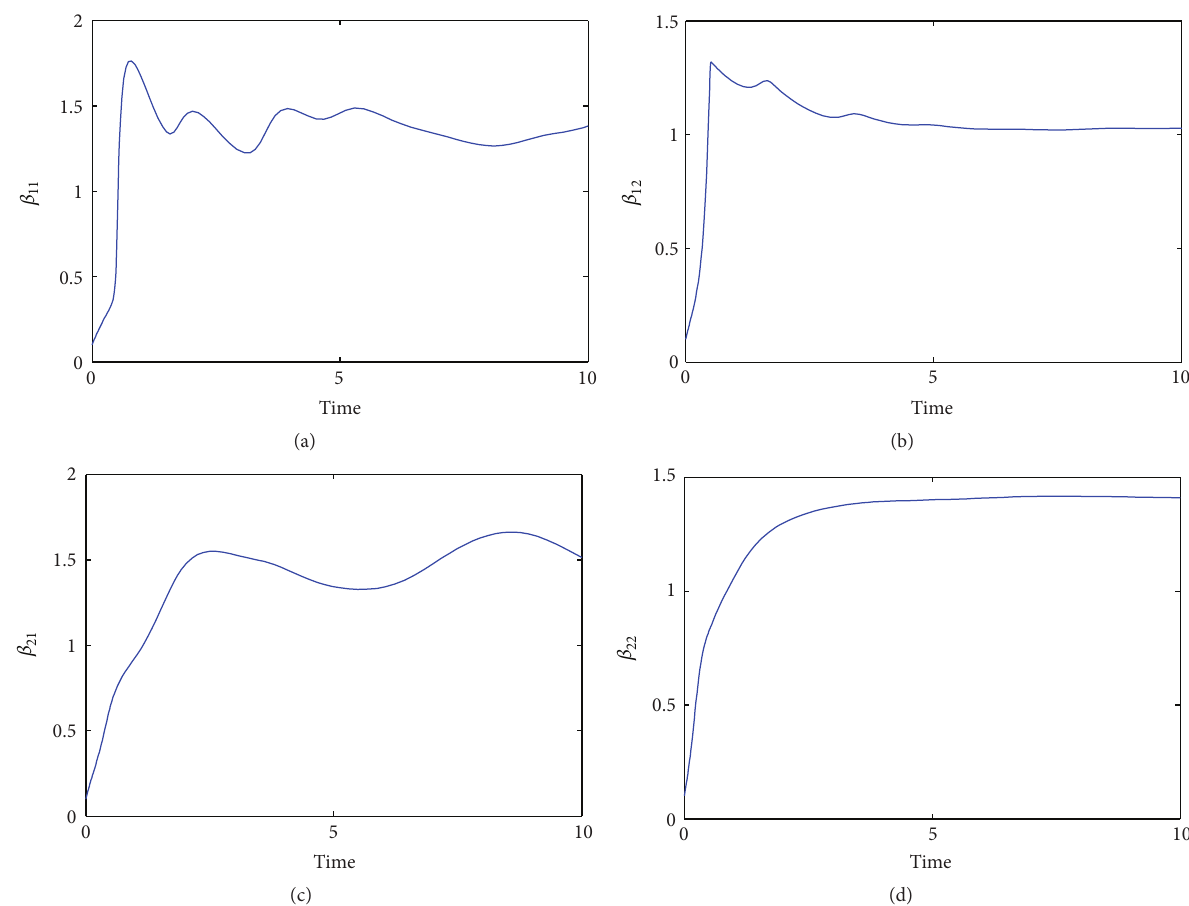
Figure 3: Simulation results of the adaptive parameters with 𝛽 ∗ 11 = 0.8 , 𝛽 ∗ 12 = 1 , 𝛽 ∗ 21 = 1.2 , and 𝛽 ∗ 22 = 1.4